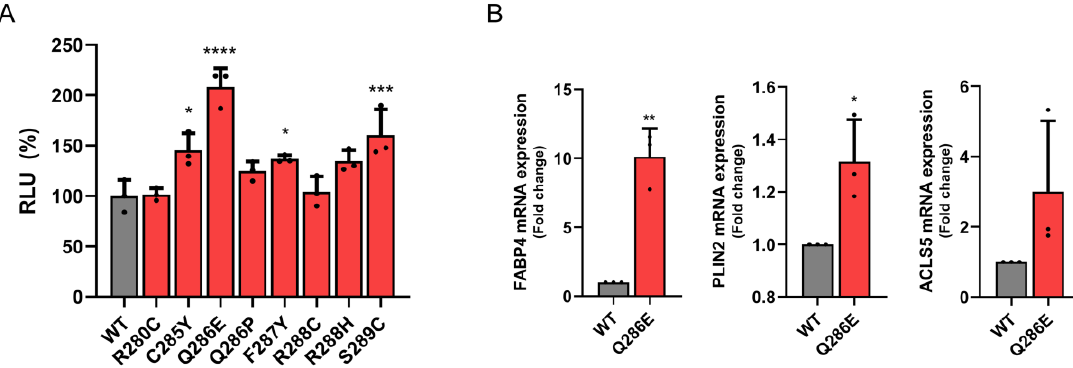
Figure 4. Transcriptional activity of PPAR γ WT and mutants. ( A ) An expression vector encoding PPAR γ full length WT or mutants (R280C, C285Y, Q286E, Q286P, F287Y, R288C, R288H and S289C) and a firefly luciferase reporter vector fused with three copies of PPAR γ response element (PPRE) sequence are co-expressed in HEK293T cells with a normalization vector containing a Renilla luciferase gene. The firefly luciferase signals normalized by Renilla luciferase signals are indicated by relative luminescence unit (RLU, %) to PPAR γ WT. The data are presented as the mean ± standard deviation (SD) of three independent experiments. The results for each mutant are compared to that for the WT in Dunnett’s multiple comparison test, * 0.01 < p < 0.05; *** 0.0001 < p < 0.001; **** p < 0.0001. ( B ) The e ff ects of PPAR γ WT and Q286E expressions on three PPAR γ target genes ( FABP4 , PLIN2 and ACLS5 ) are measured by RT-qPCR. The expression of PPAR γ target genes is normalized against the basal expression of human 60S ribosomal protein L 32. The data are presented as the mean ± SD of three independent experiments. The result for the Q286E is compared with that for the WT in Student’s t -test, * 0.01 < p < 0.05; ** p <